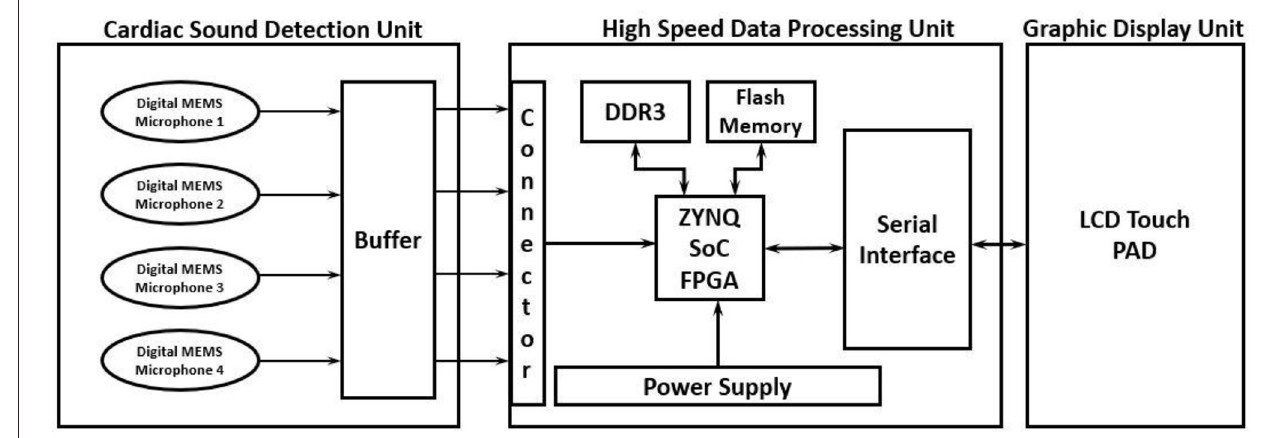
FIGURE 1 | Phonocardiography system block diagram.